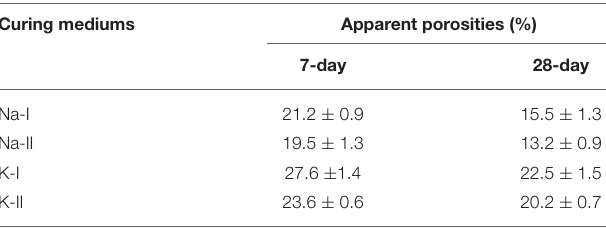
TABLE 5 | The apparent porosities of the 7- and 28-day ambient temperature cured samples.